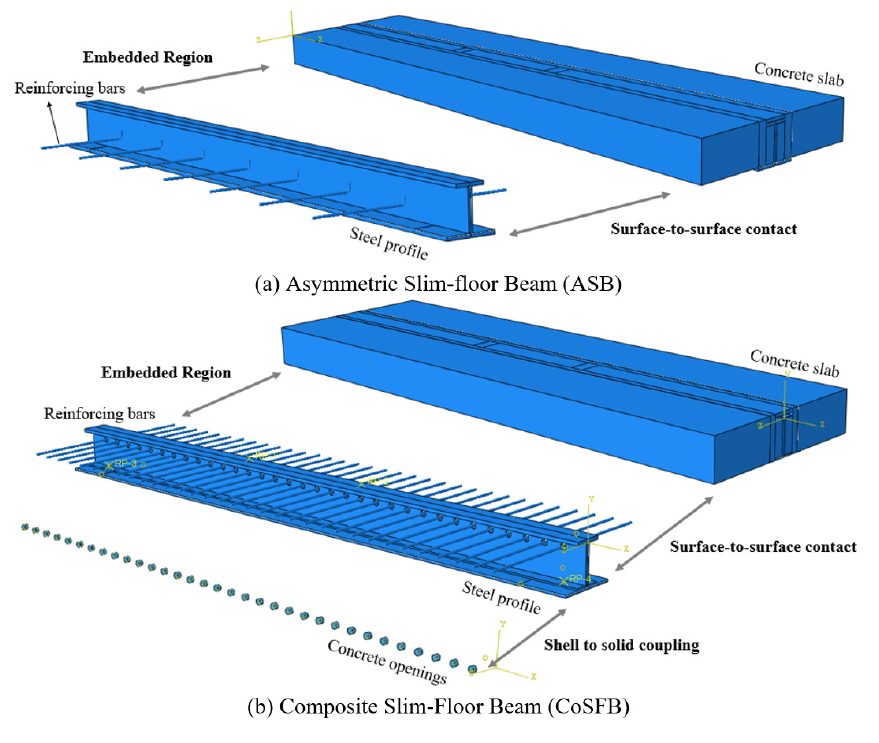
Figure 13. Component